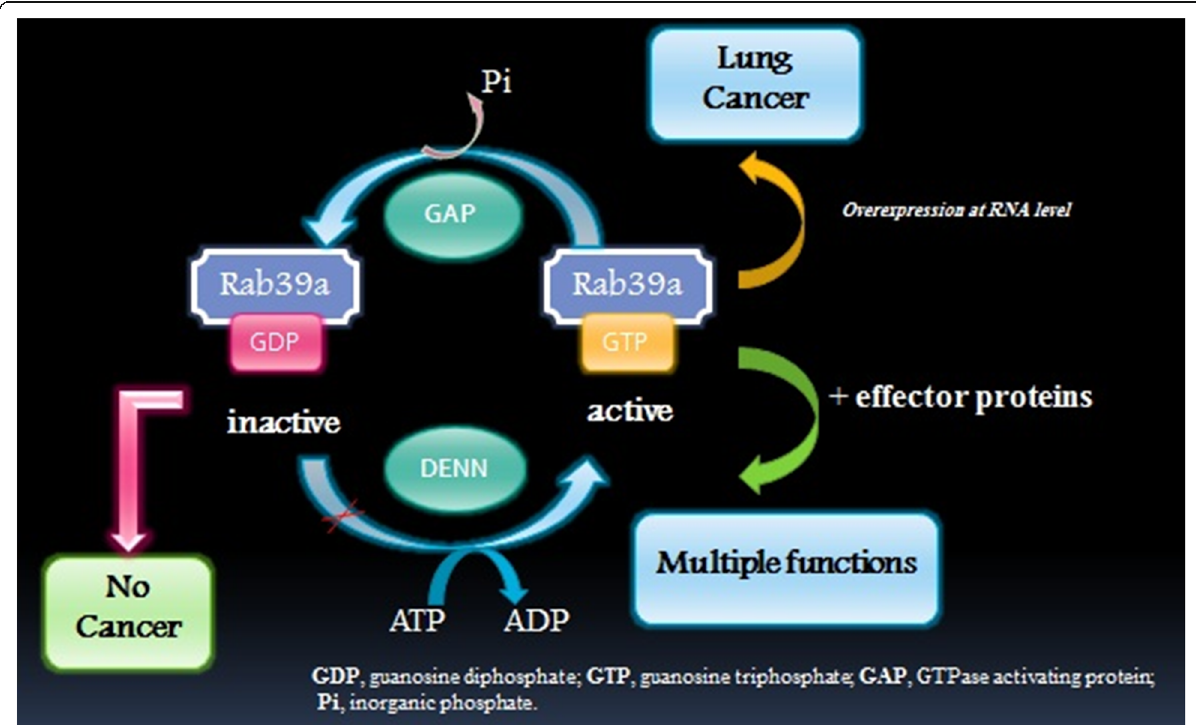
Fig. 1 Biochemical pathway of Rab39a: The human Rab39a cycle between the active GTP-bound (membrane-associated) and inactive GDP-bound (cytosol-associated) conformations using DENN as guanine nucleotide exchange factor (GEF) and GTPase-activating protein (GAP). Rab39a is involved in regulation of cellular endocytosis pathway along Golgi-associate vesicular transport. Alteration in Rab39a has been implicated in causing lung cancer [5, 8, 9]